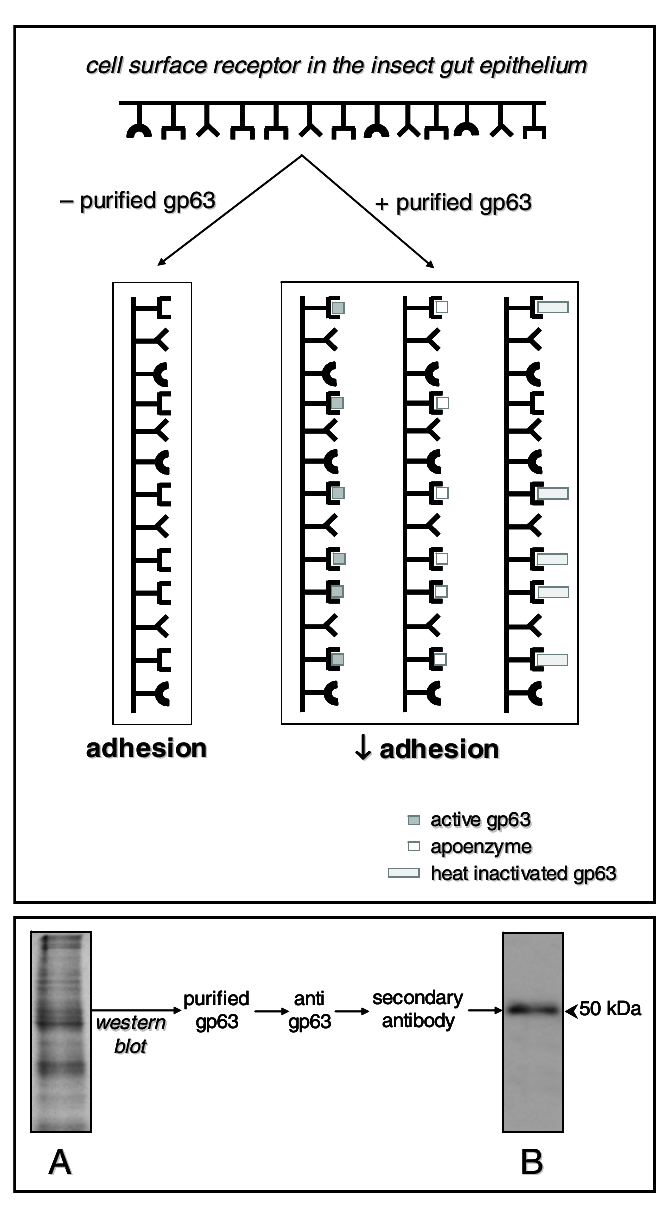
Fig. 9 – Different approaches employed for the demonstration of a proposed role performed by the gp63-like cell surface molecules on the interaction of lower trypanosomatids with the invertebrate gut epithelial cells. Schematic representation of the inhibition